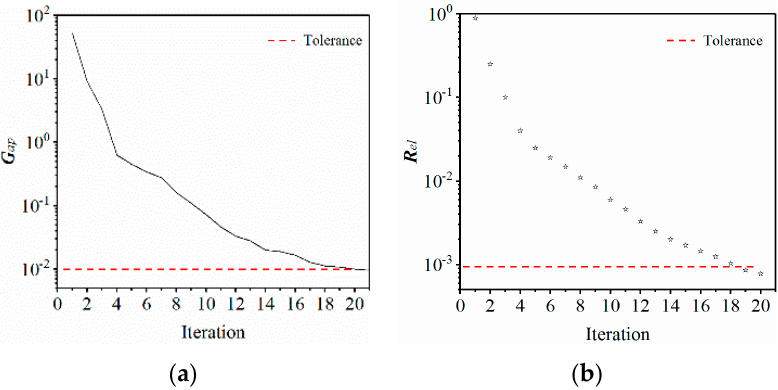
Figure 12. The convergence of the ATC-based distributed method: ( a ) Feasibility, ( b ) Optimality.